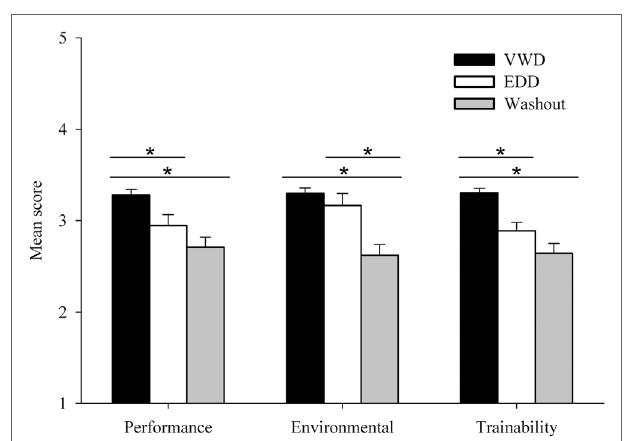
FigUre 1 | Average scores for each group [VW dog (VWD), explosives detection dog (EDD), Washout] in the Performance, Environmental, and Trainability domains. Mean scores represent averages of submeasures corresponding to each domain and are collapsed across timepoints. Error bars represent standard errors of the means. * p <